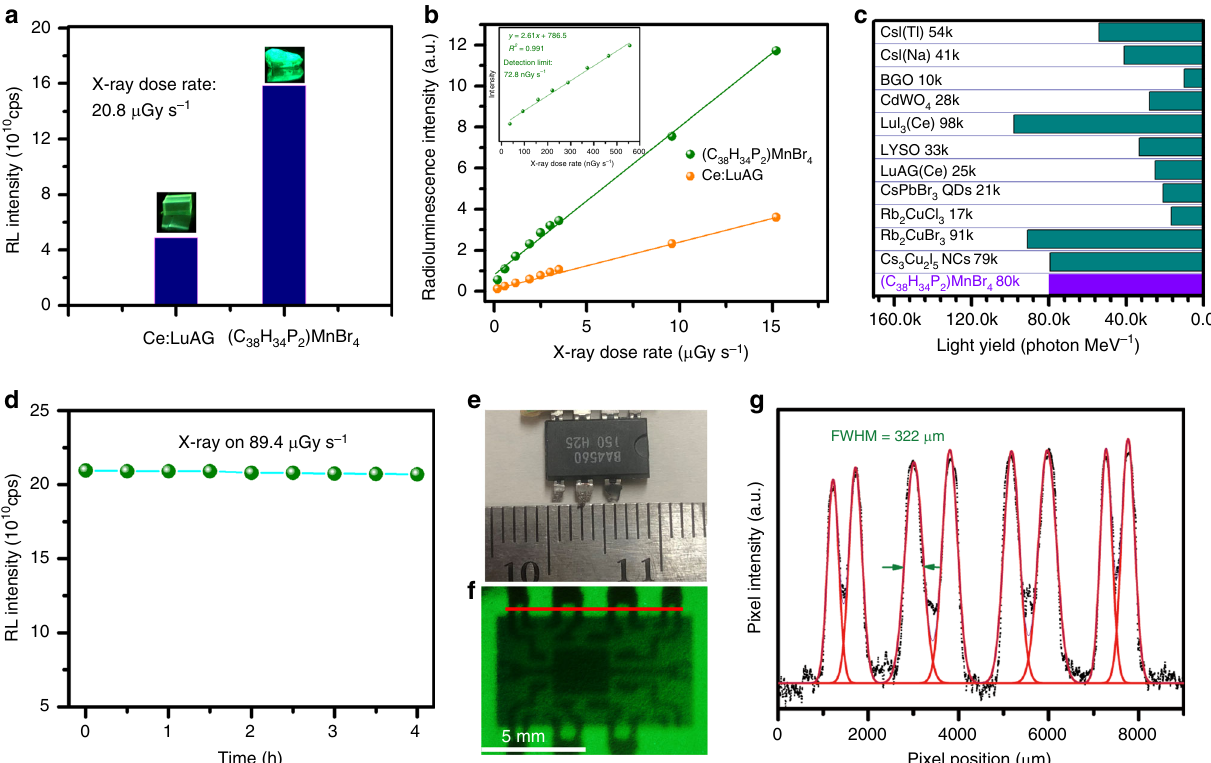
Fig. 2 X-ray scintillation properties of (C 38 H 34 P 2 )MnBr 4 . a Comparison of RL intensities for the standard reference Ce:LuAG and (C 38 H 34 P 2 )MnBr 4 under dose rate of 20.8 μ Gy s − 1 . The inset shows the corresponding images under the same X-ray irradiation. b Dose rate dependence of the RL intensity of standard reference Ce:LuAG and (C 38 H 34 P 2 )MnBr 4 . The inset shows the detection limit measurement under low X-ray dose for (C 38 H 34 P 2 )MnBr 4 . The detection limit can be achieved when the RL intensity is three times higher than the background intensity. c Comparison of scintillator light yields of (C 38 H 34 P 2 )MnBr 4 and previously reported and commercially available scintillators. d The change of the RL intensity under continuous X-ray excitation with a dose rate of 89.4 μ Gy s − 1 . e Image of a speaker chip under bright- fi eld. f The X-ray images of the speaker chip by using (C 38 H 34 P 2 )MnBr 4 scintillator screen, acquired with a digital camera. g Spatial resolution measurement by the fi tting of intensity spread pro fi le with Gaussian function. The FWHM was taken as resolution. The red line in f shows the data trace of